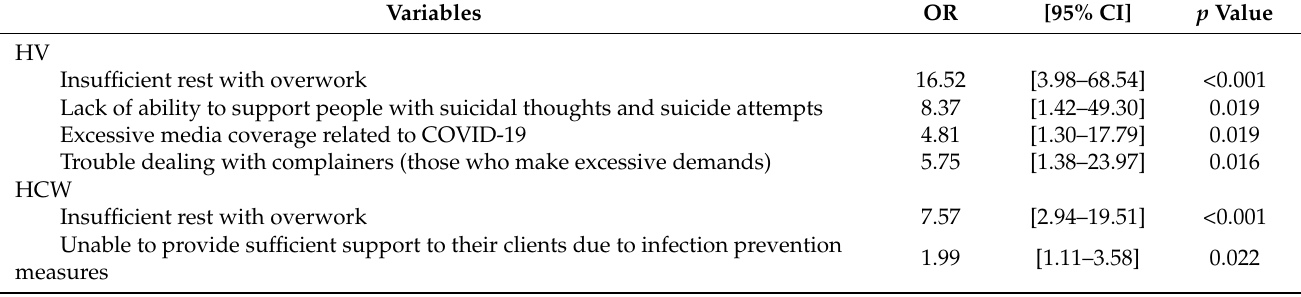
Table 3. Association Between Variables and Psychological Distress in Binomial Logistic